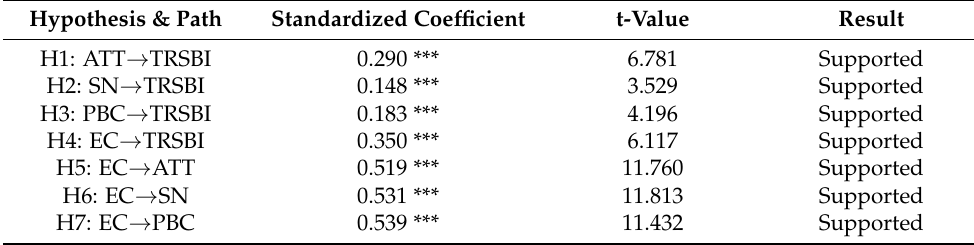
Table 3. Structural model assessment and hypothesis examination